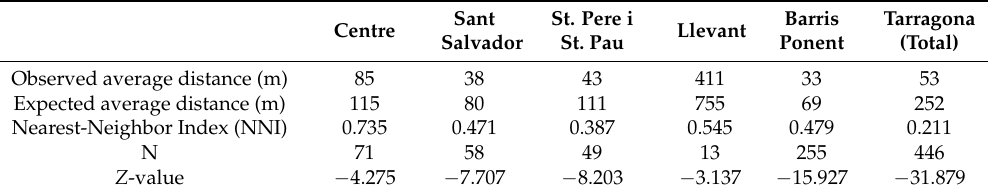
Table 1. Nearest-Neighbor Index (NNI) for neighborhoods in